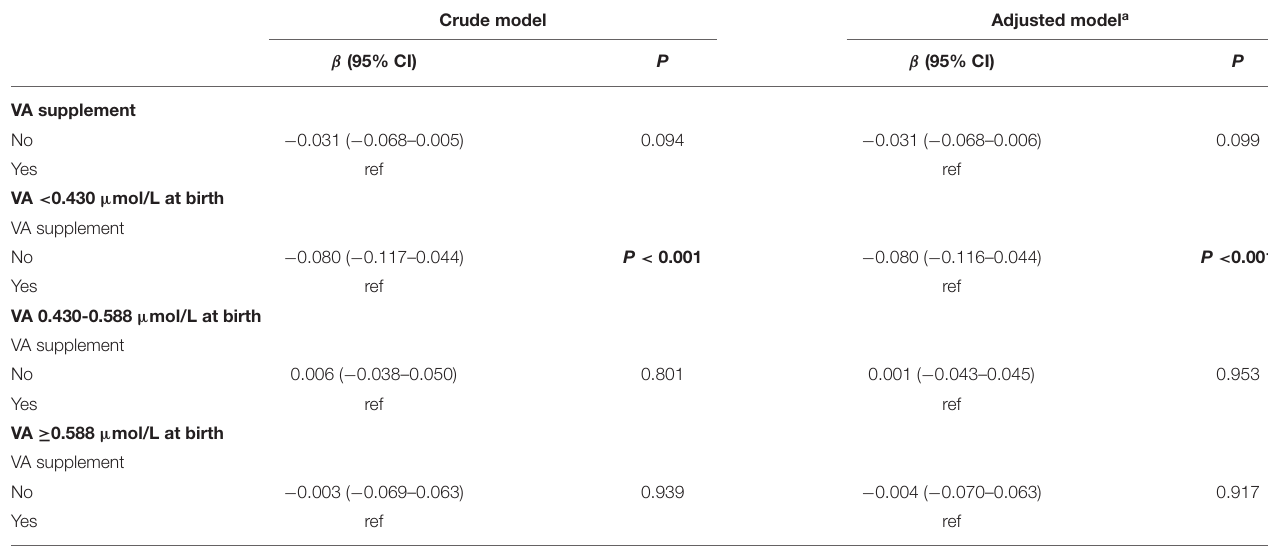
a Adjusted for: feeding pattern (Breast feeding vs. Mixed feeding vs. Artificial feeding), sex (Female vs. Male); P-Value for interaction between the vitamin A supplementation variable and age in both crude model and adjusted model < 0.05. VA, vitamin A; CI, confidence interval. Bold P-values mean